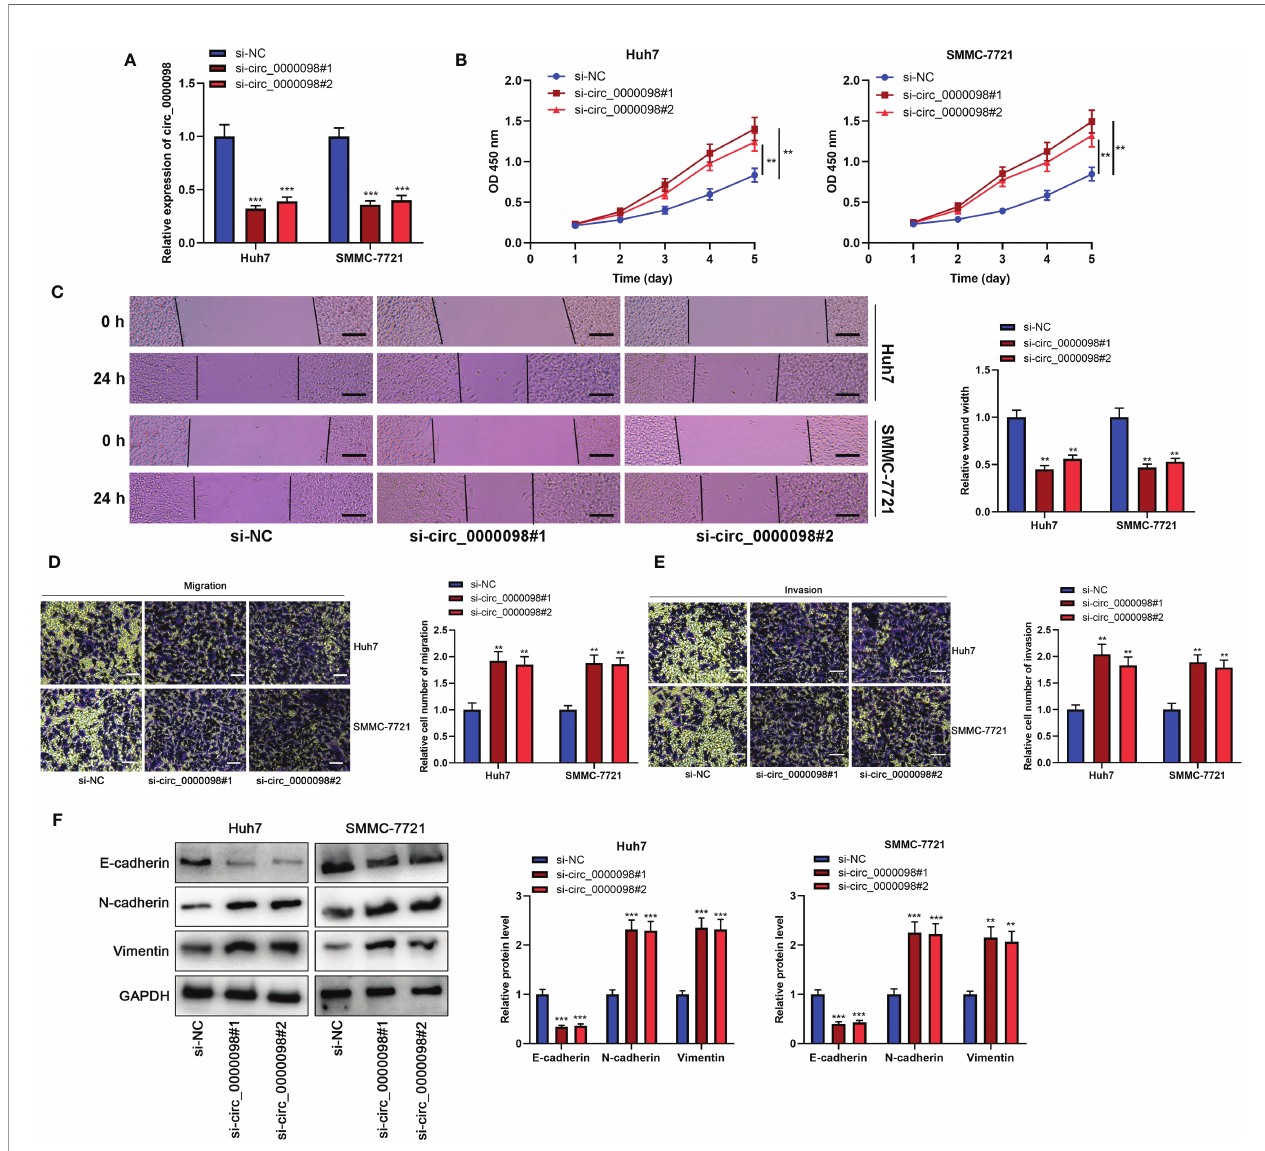
FIGURE 2 | Knocking down circ_0000098 promoted the proliferation, migration, and invasion of HCC cells. (A) qRT-PCR was used to detect the expression of circ_0000098 in Huh7 and SMMC-7721 cells after the transfection of si-circ_0000098#1 and #2. (B) CCK-8 assay was used to evaluate cell proliferation. (C) The migration ability of cells was detected by wound healing assay (Scale bar, 100 m m). (D, E) Transwell assay was used to detect cell migration and invasion (Scale bar, 250 m m). (F) Western blot assay was used to detect the expression levels of E-cadherin, N-cadherin, and Vimentin in Huh7 and SMMC-7721 cells with down- regulated circ_0000098 expression. ** P < 0.01 and *** P <